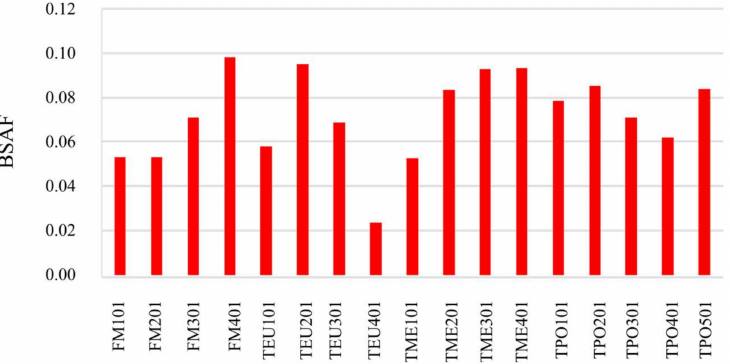
Figure 5. BSAFs for total Hg in the water bodies of the Marano and Grado